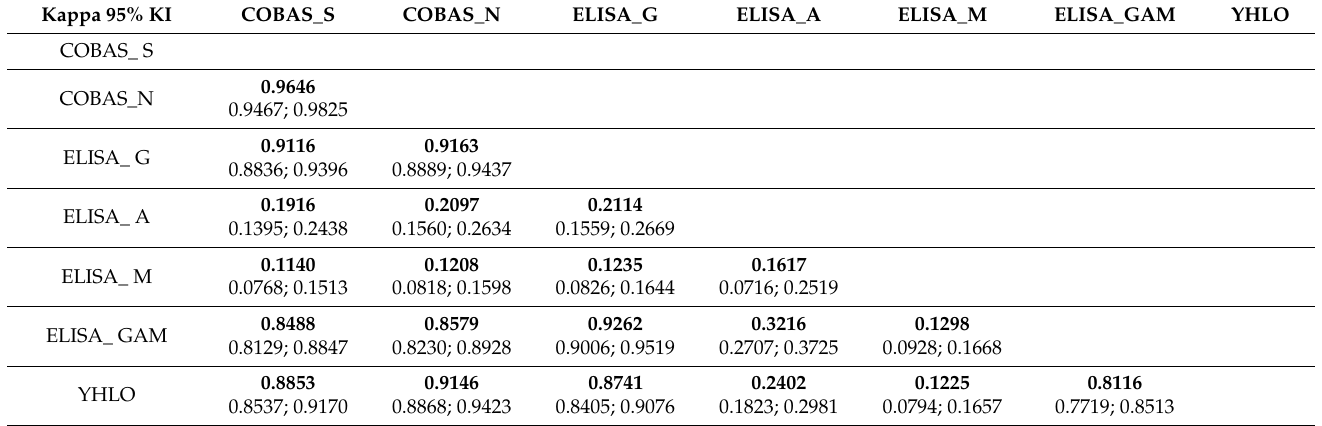
Table 2. Agreement of dichotomous (seronegative vs. seropositive) test results within the complete group ( n = 856 weighted to n = 4185) estimated by Cohen’s kappa (bold) with